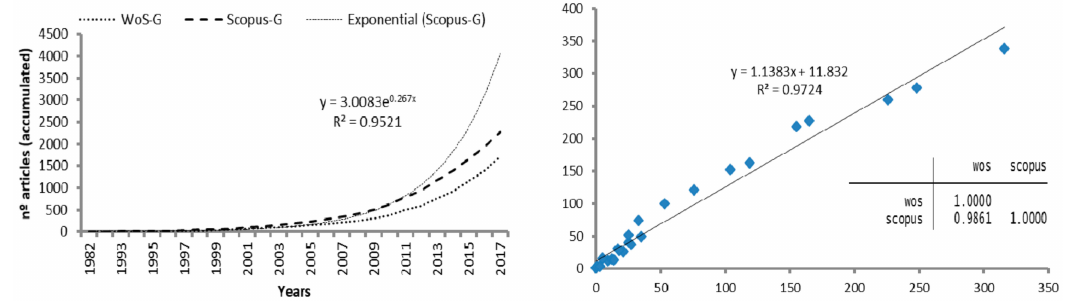
Figure 4. Growth and Correlation of citations received per year. Source: The authors’ own